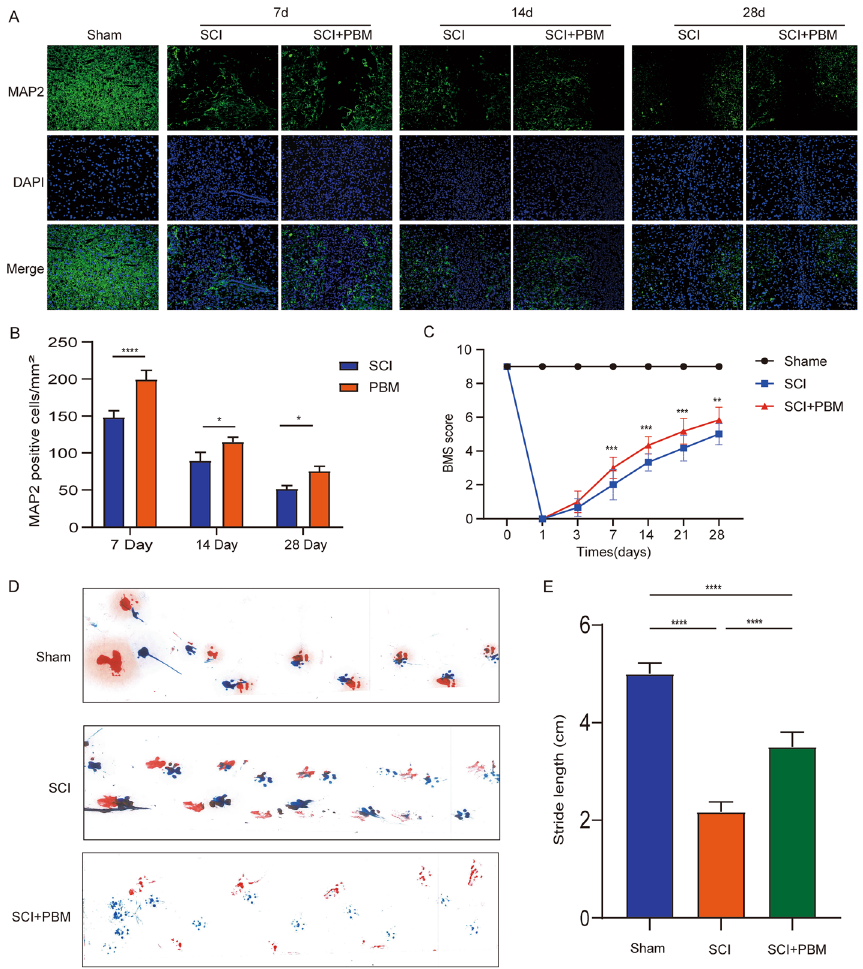
Fig. 8 PBM promotes neuronal survival and motor function recovery after SCI. A , B Immunofluorescence was used to stain neurons at 7, 14, and 28 days after SCI. Compared with the injured group, PBM can promote the survival of neurons ( n 3 per group). Scale bar, 200 μm. C The BMS score was used to evaluate the recovery = of motor function in mice at 1, 3, 7, 14, and 28 days after SCI ( n 6 per group). D , E At 28 days, the footprints = of each group were obtained by gait analysis, The average step length is counted ( n 6 per group). * P < 0.05, = *** P < 0.001, *** P < 0.001, **** P <